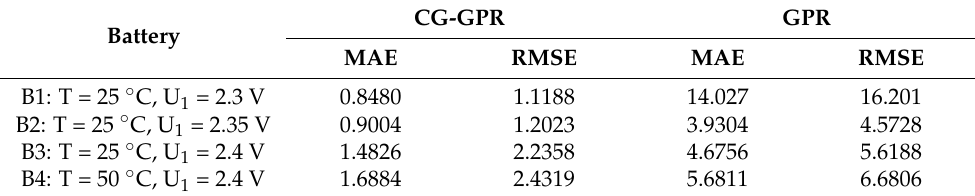
Table 3. The error